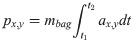
One of the two accelerometer signals in a strike on the punching bag.The impulses of the punch are equal to the shaded area under the curves times the mass of the punching bag px,y=mbag∫t1t2ax,ydt, with t1 30 ms before the threshold (7 m·s2) is passed and t2 the time of the first zero crossing. The total impulse p is calculated as the vector sum of the two perpendicular components: p=px2+py2. The accelerations measured after the first zero-crossing are due to vibrations and swinging of the bag after the strike.